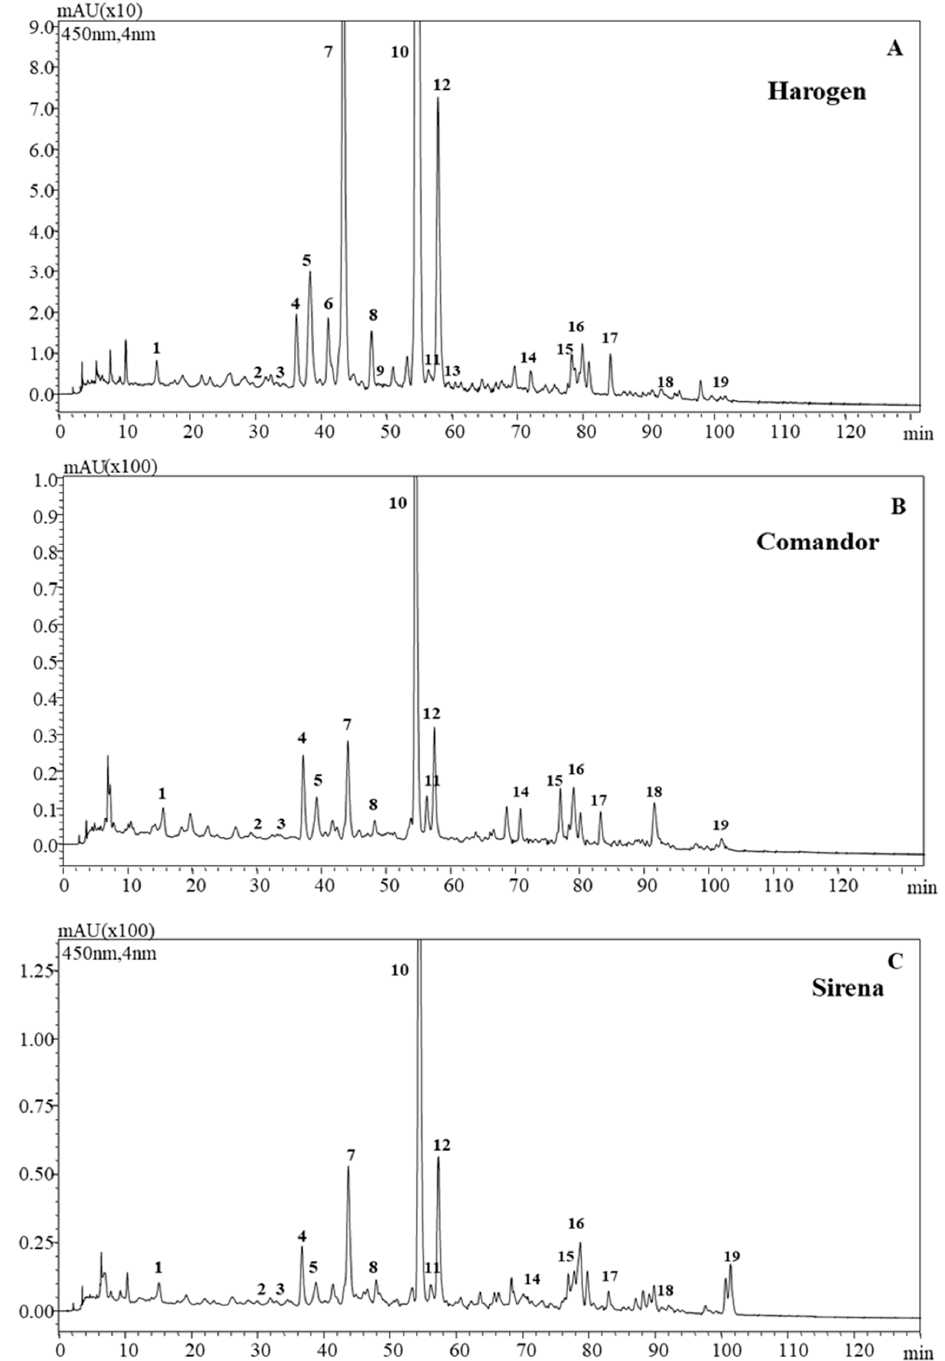
Figure 1. High performance liquid chromatography (HPLC) chromatograms (recorded at 450 nm) of carotenoid extracts from three selected apricot cultivars. (A) Harogem cultivar A1; (B) Comandor cultivar A2; (C) Sirena cultivar A3. For peak assignment see Table 1. Table 1. UV-Vis and MS APCI (+) and APCI ( − ) information and identi fi cation of the carotenoids in the analyzed apricots cultivars.